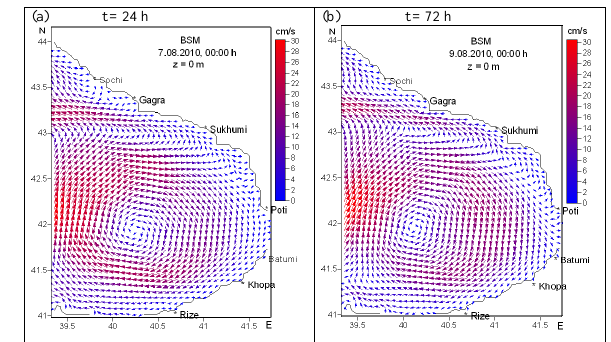
Fig. 4. Salinity field (psu) at 5.08.2010, 00:00 h on depths of 0 m (a) and 100 m (b).